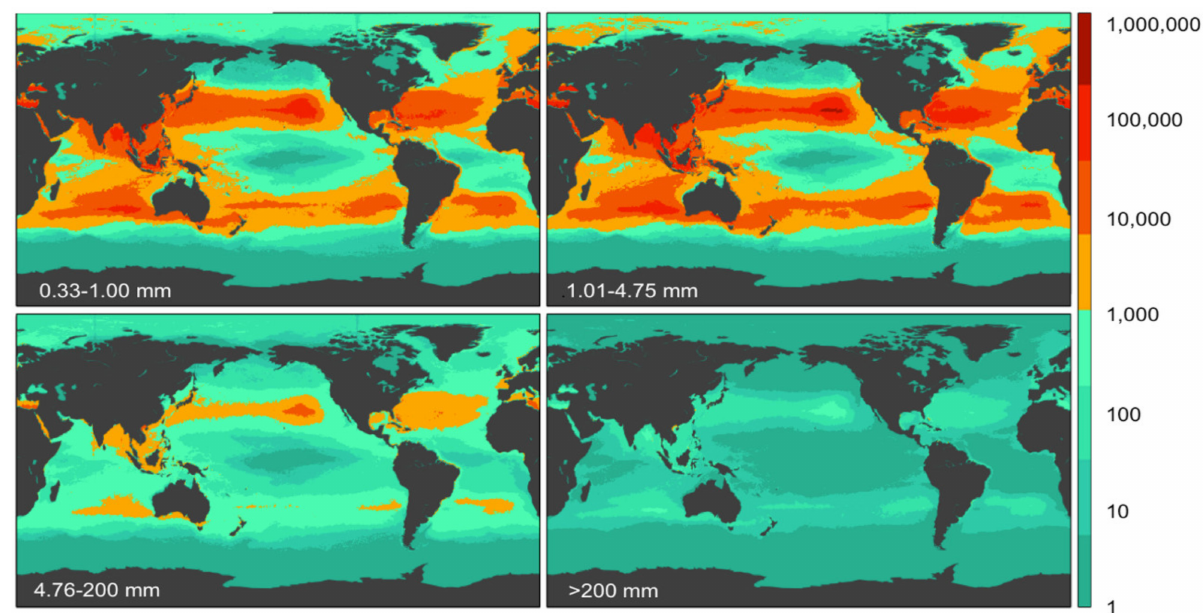
Figure 3. Model results for global count density in four size classes